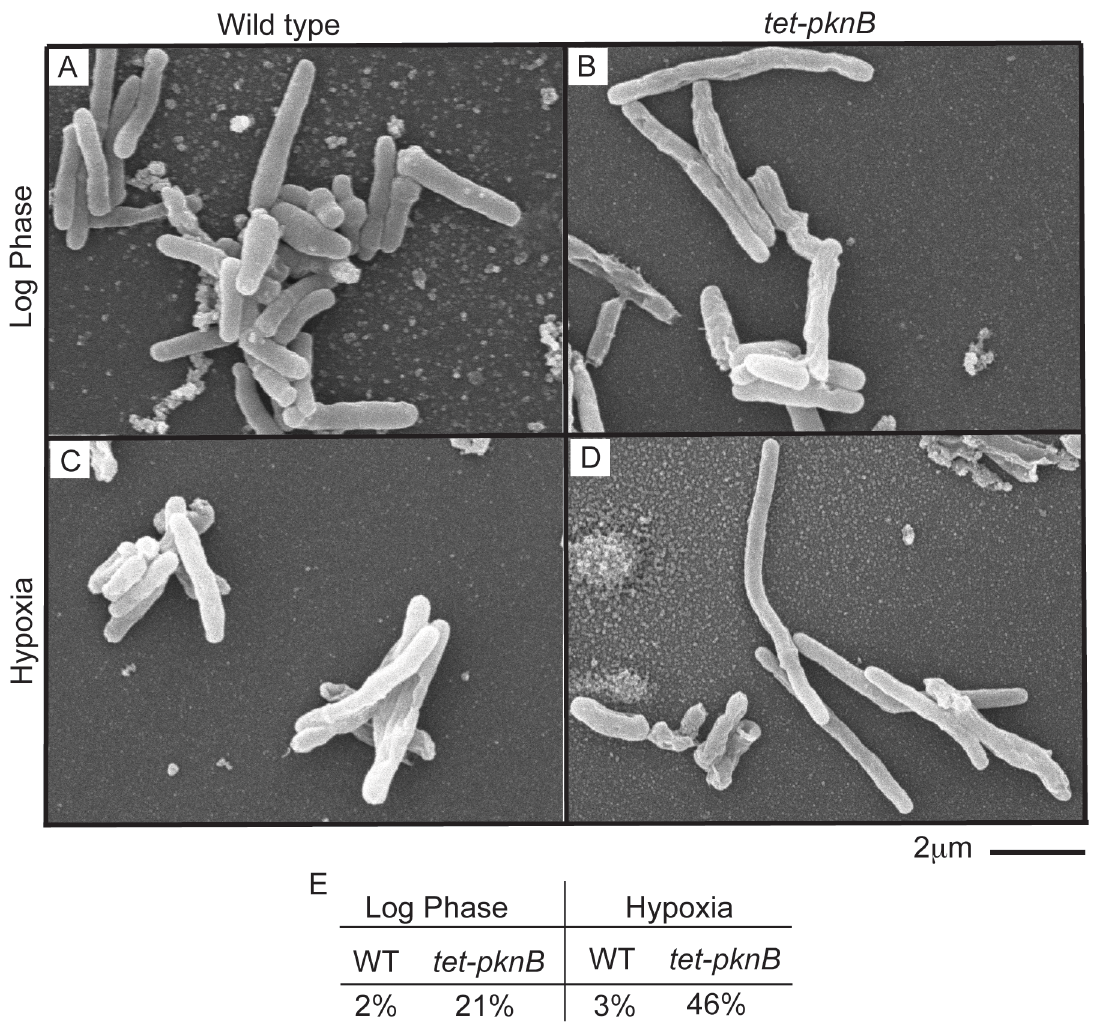
Figure 7. PknB overexpression leads to elongated bacilli in hypoxia. Scanning electron microscopy of (A) wild-type and (B) tet-pknB on day 0 (log phase), and (C) wild-type and (D) tet-pknB after 7 d of hypoxia. (E) The percent of elongated bacilli for each strain in log phase and